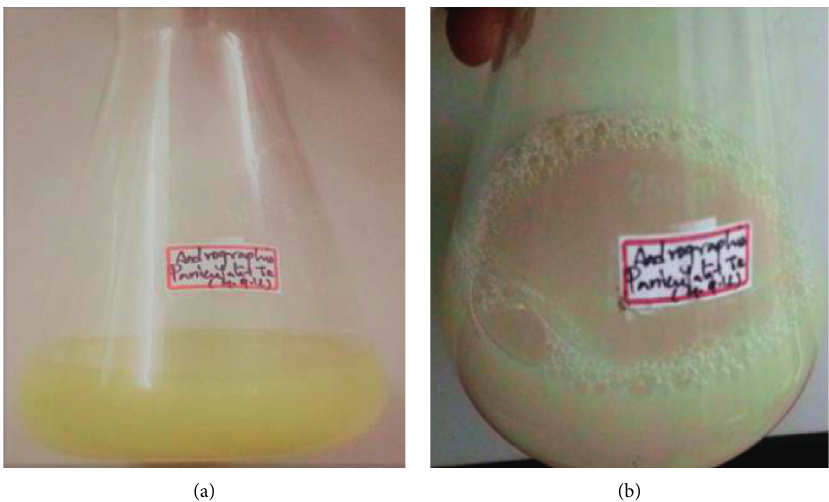
Figure 1: Visual observation of (a) A. paniculata plant extract (b) and synthesized TiO